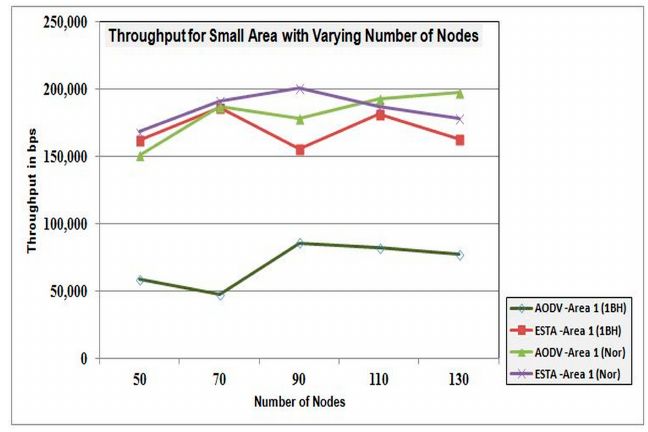
Figure 17. Throughput for varying nodes in a small area.